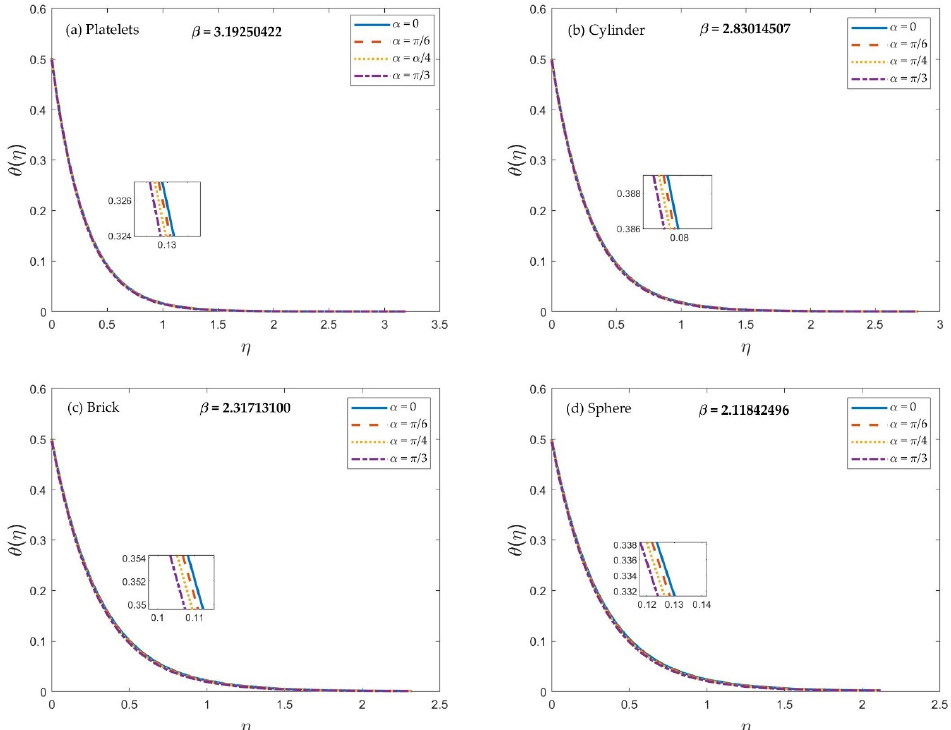
Figure 6. Impact of the inclination angle parameters 𝛼 on the temperature profile for 𝑆 = 0.4 , 𝐾 = 0.5 , 𝜑 = 0.02 , 𝑀 = 1.0 , 𝐵𝑖 = 3.0 , 𝜆 = −2.0 and 𝑃𝑟 = 8.0 .